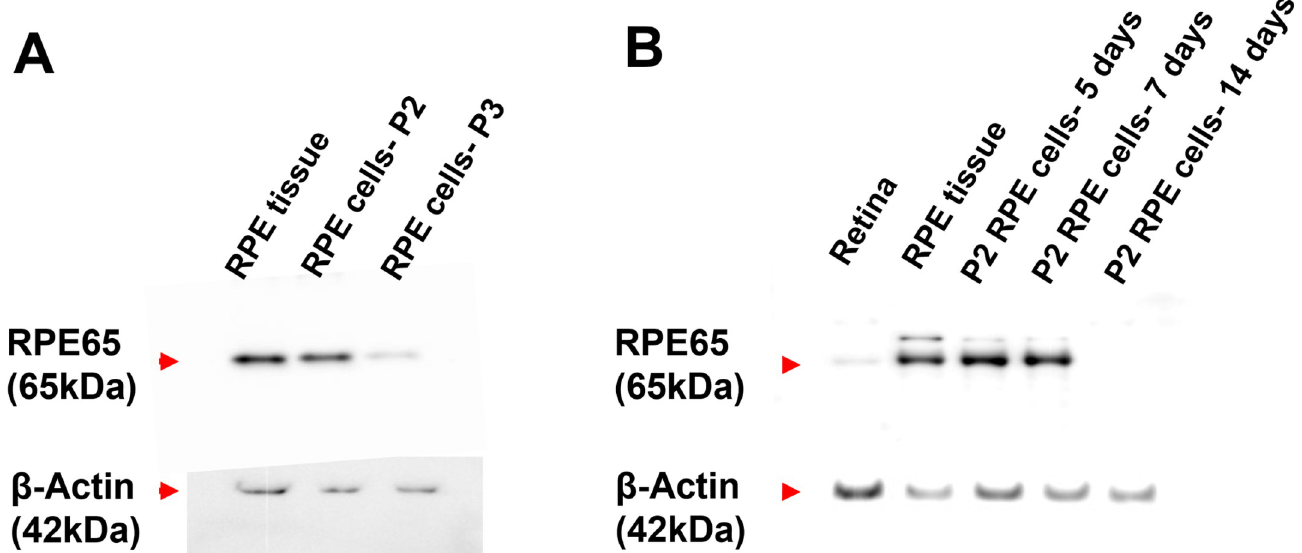
Fig 4. Characterisation of cultured primary porcine RPE cells. (A) The expression of RPE marker RPE65 in different passages of the cultured primary RPE cells. After 7 days of culture, passage 2 RPE cells showed higher expression of RPE65 than passage 3. RPE tissue was used as a positive control. (B) The expression of RPE65 in passage 2 RPE cells cultured for 5, 7 and 14 days. The passage 2 RPE cells expressed RPE65 up to 7 days, but the expression was absent after 14 days of culture. Whole tissues of RPE and retina were used as positive and negative controls respectively. (n = 3).